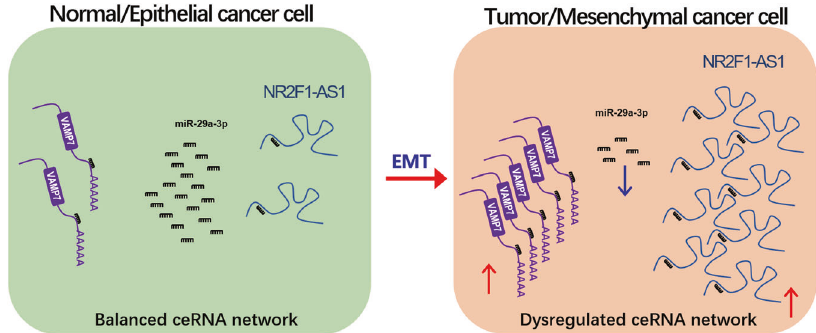
Fig. 8 Hypothetical working model of lncRNA NR2F1-AS1 in GC. NR2F1-AS1 expression was greatly upregulated in GC, especially in metastatic GC cells with mesenchymal phenotypes. In the normal gastric cells or the epithelial GC cells, the ceRNA network, composed of NR2F1-AS1, miR-29a-3p and VAMP7, is balanced. After tumorigenesis or initiation of EMT, the ceRNA network is dyregulated, resulting in overexpression of the oncogene VAMP7, which ultimately drives GC